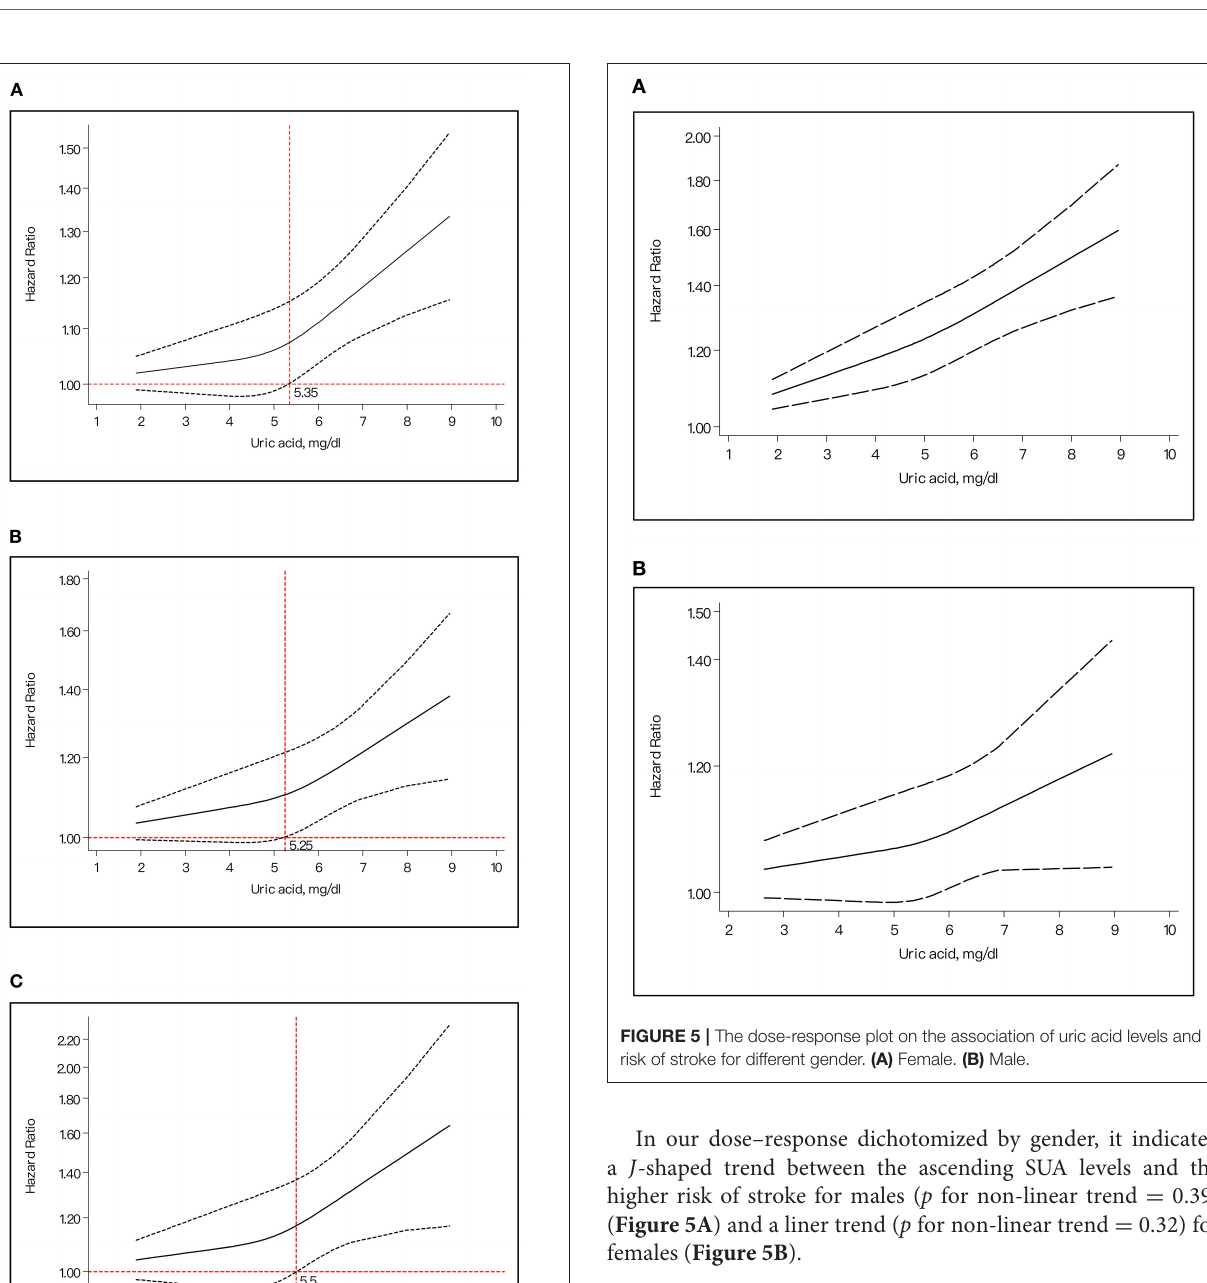
In our dose–response dichotomized by gender, it indicated a J -shaped trend between the ascending SUA levels and the higher risk of stroke for males ( p for non-linear trend = 0.39) ( Figure 5A ) and a liner trend ( p for non-linear trend = 0.32) for females ( Figure 5B